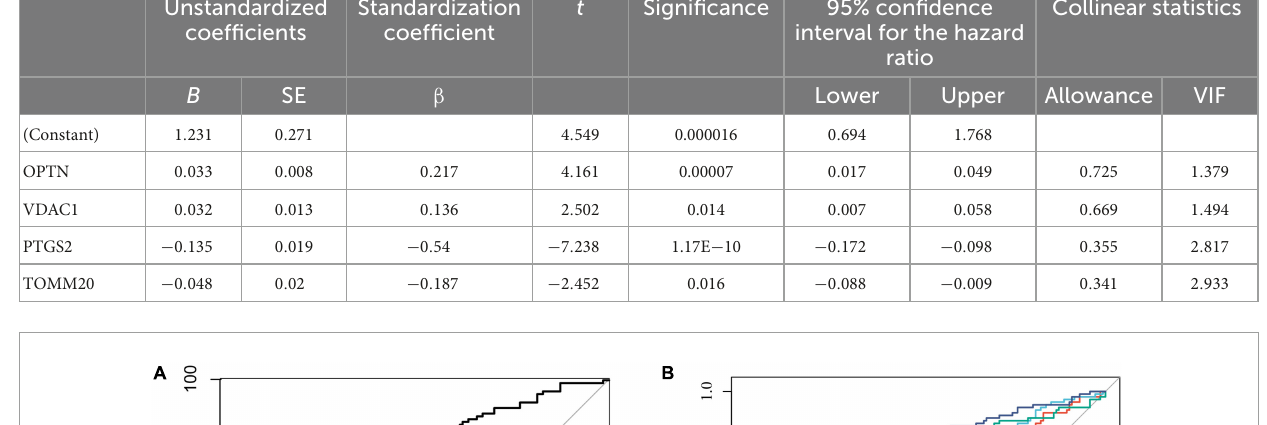
TABLE 3 Multivariate logistic regression analysis of four genes.